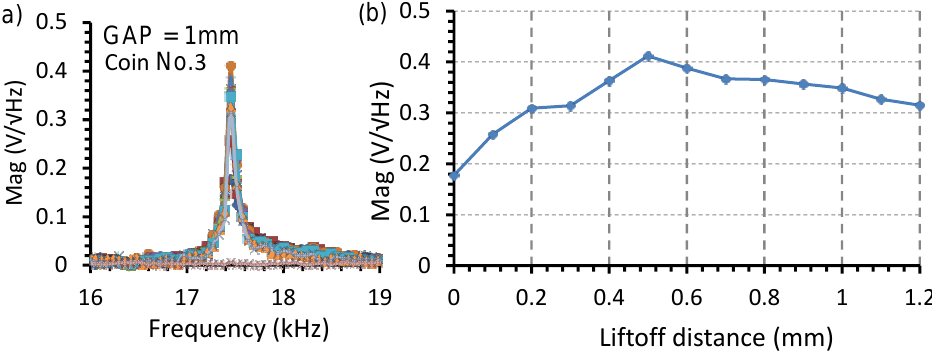
Figure 9. The natural frequency response of the coin with the different gap sizes of ( a ) 1, ( b ) 2.5, ( c ) 3.5, ( d ) 4.5, and ( e ) 8.5 mm. The corresponding diameters for the inner magnet are 25, 22, 20, 18, and 10 mm. ( f ) The magnitudes of the sound signal for the possible counterfeit B coin.